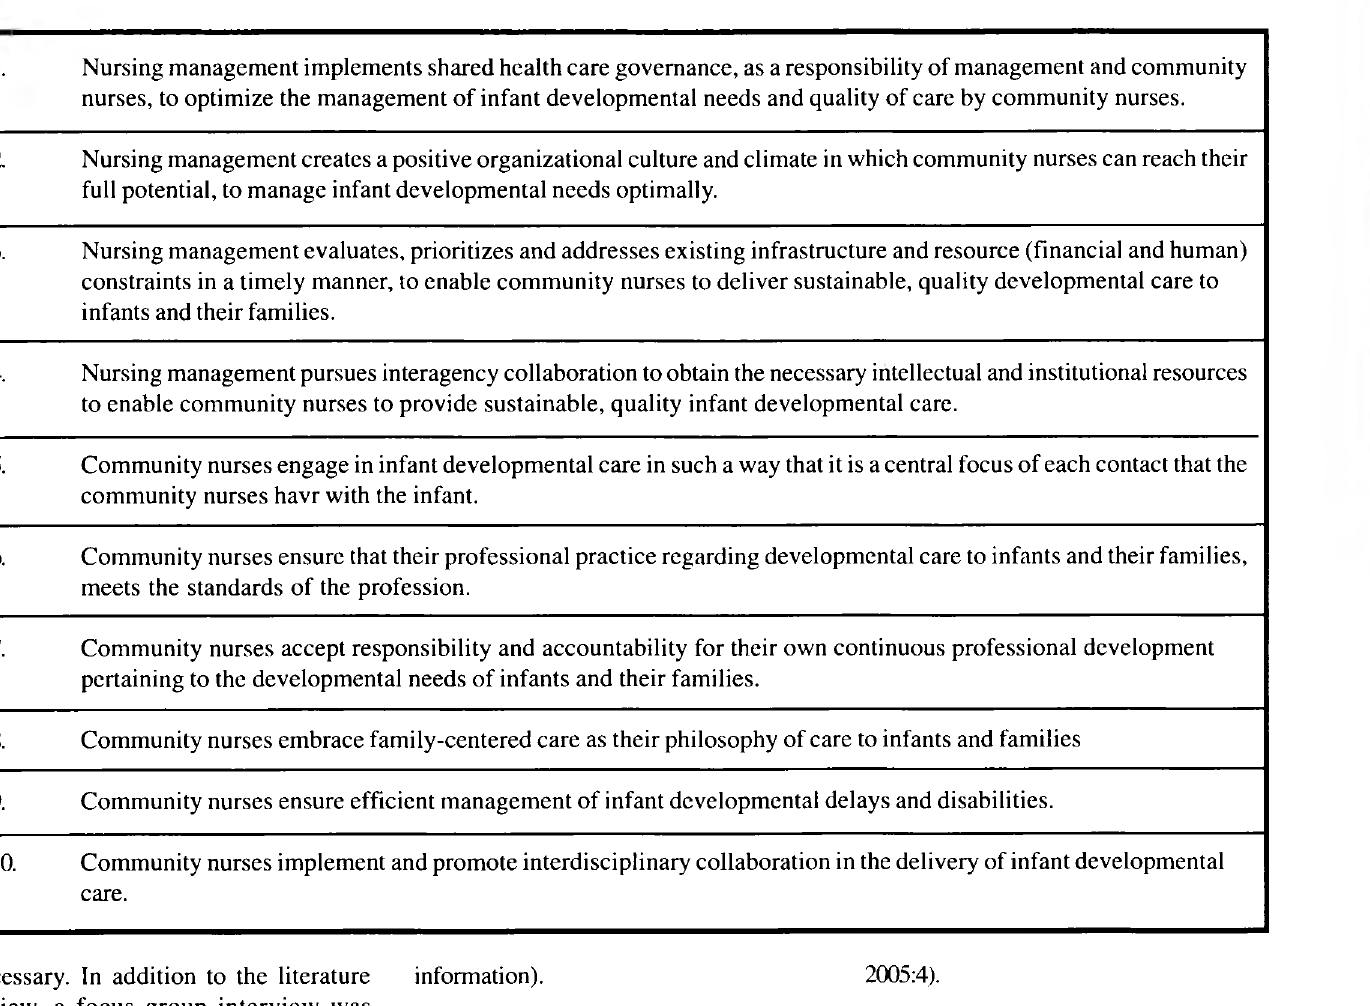
Table 1: Recommended